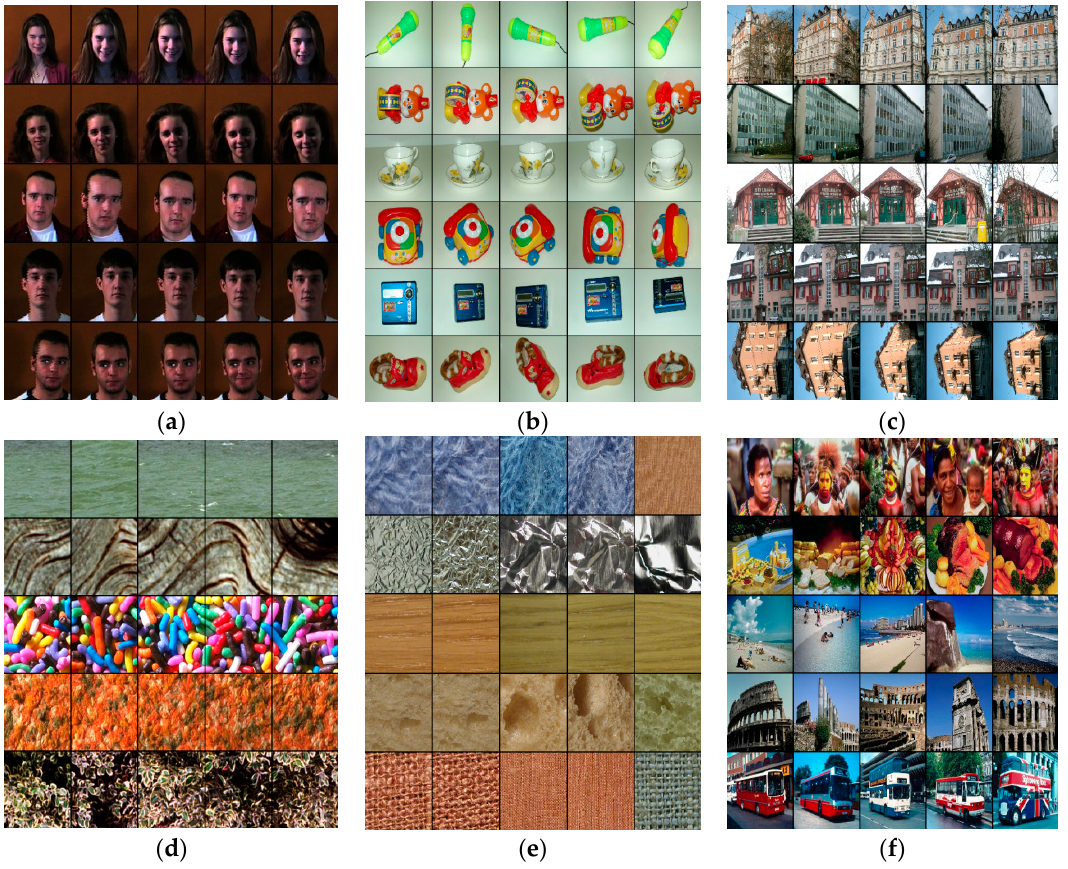
Figure 6. Some samples from six datasets: ( a ) Face-95; ( b ) ETHZ; ( c ) ZuBuD; ( d ) VisTex; ( e ) KTH-2a; and ( f )